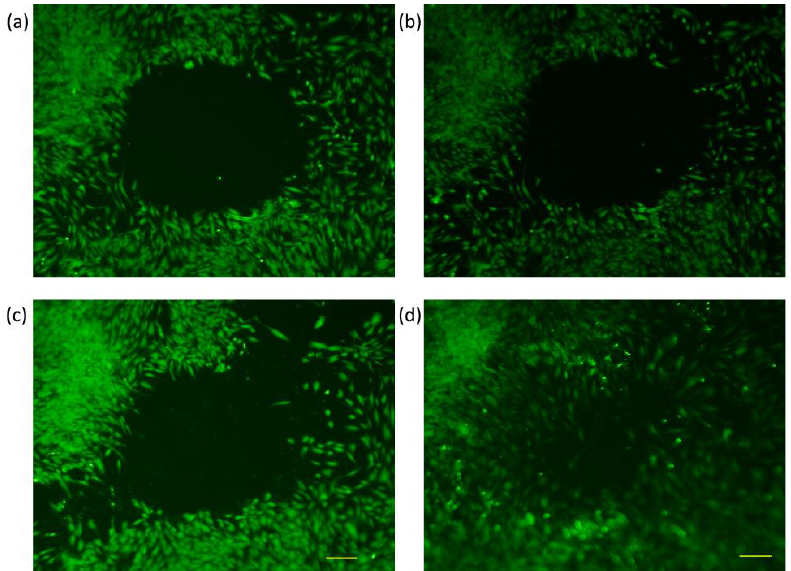
Figure 5. Fluorescence microscopy images of dermal fibroblasts from a 28-year-old donor at four different time frames (Control Group) ( a ) Initial, ( b ) 24 h, ( c ) 48 h, and ( d ) 4 days.